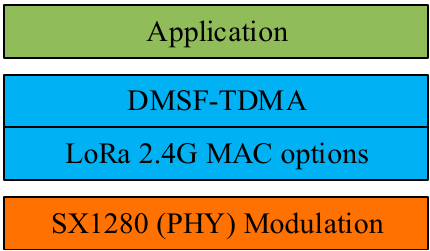
Figure 8. Protocol Figure 8. Protocol architecture.